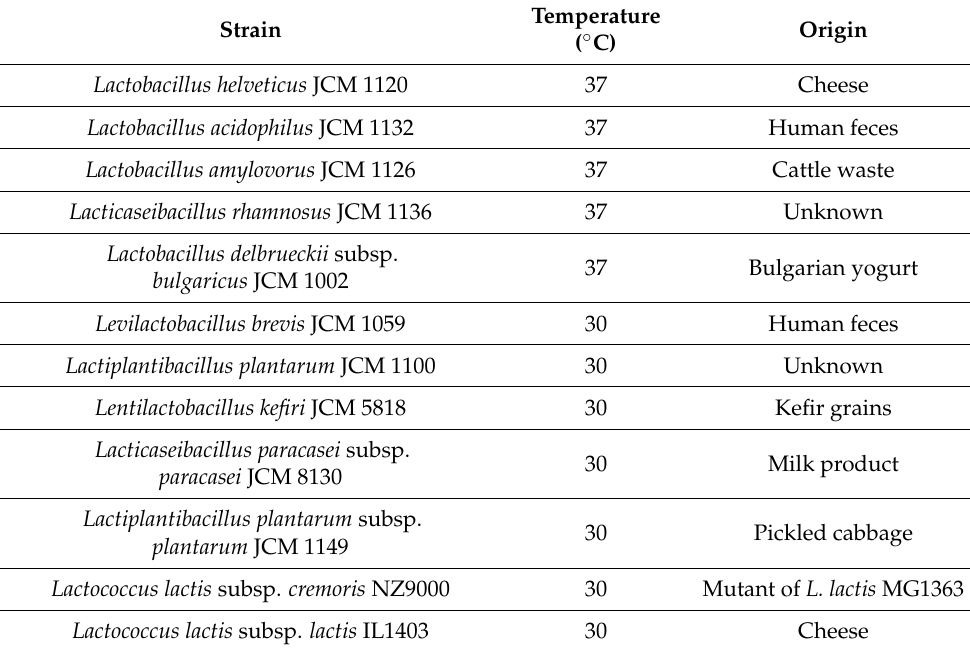
Table 1. Lactic acid bacteria and culture incubation